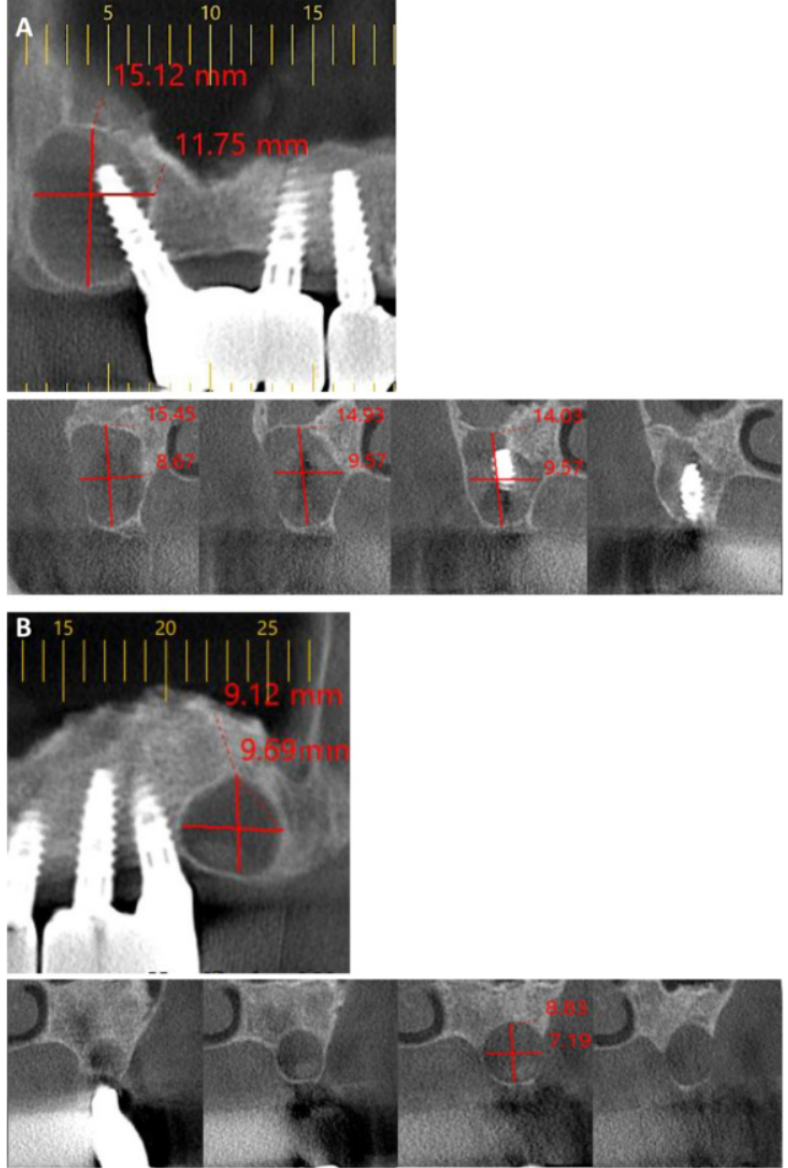
Figure 2. Cone-beam computerized tomography (CBCT) of the surgical ciliated cysts in present case #4-5—partial pseudo-panoramic reconstruction and appropriate transaxial slices, right maxilla, ( A ) and left maxilla ( B ).